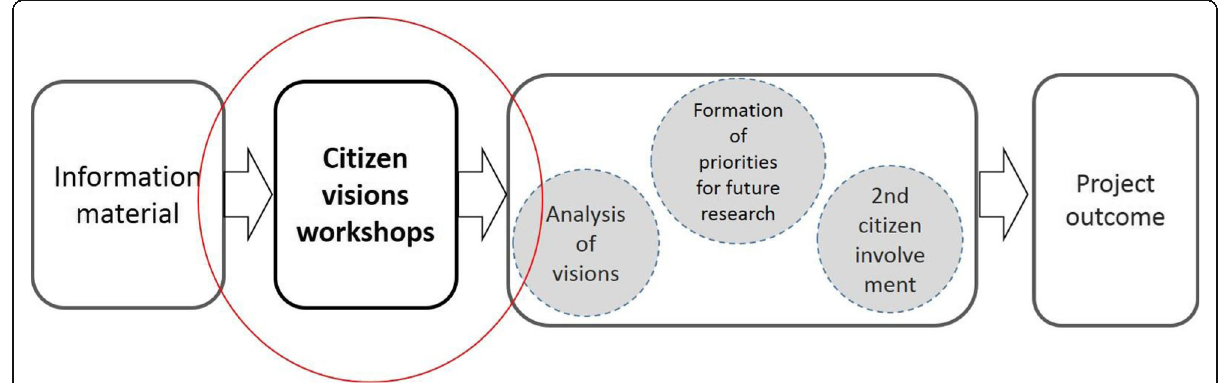
Fig. 1 Process towards research priorities (concept outlined by the